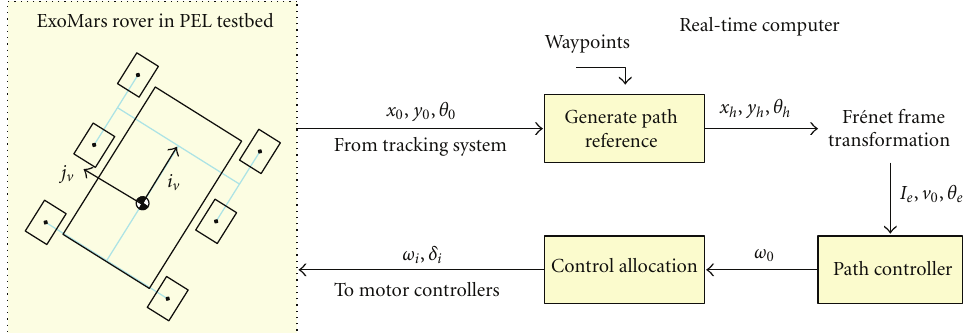
Figure 5: Block diagram of the path-following control in nominal mode.